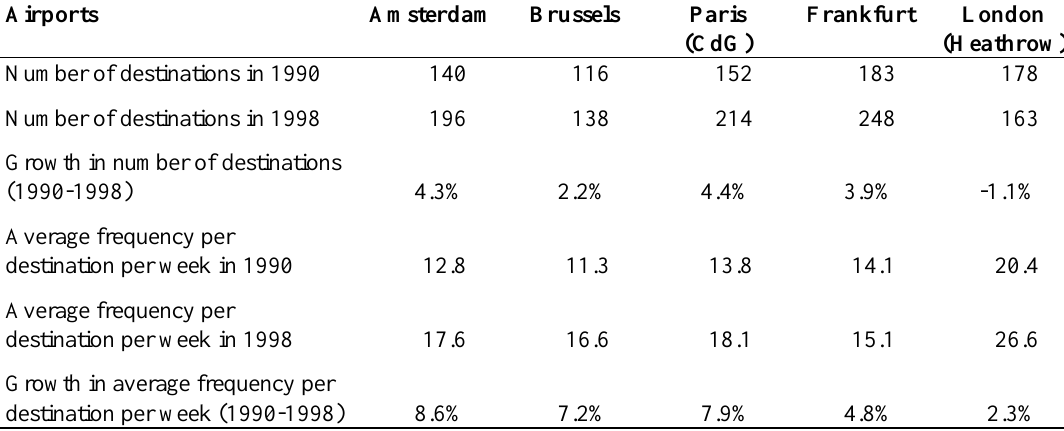
Table 2. Network development of Amsterdam Airport Schiphol and competing airports in the period 1990-1998 (direct scheduled-service links passengers and cargo craft) Airports